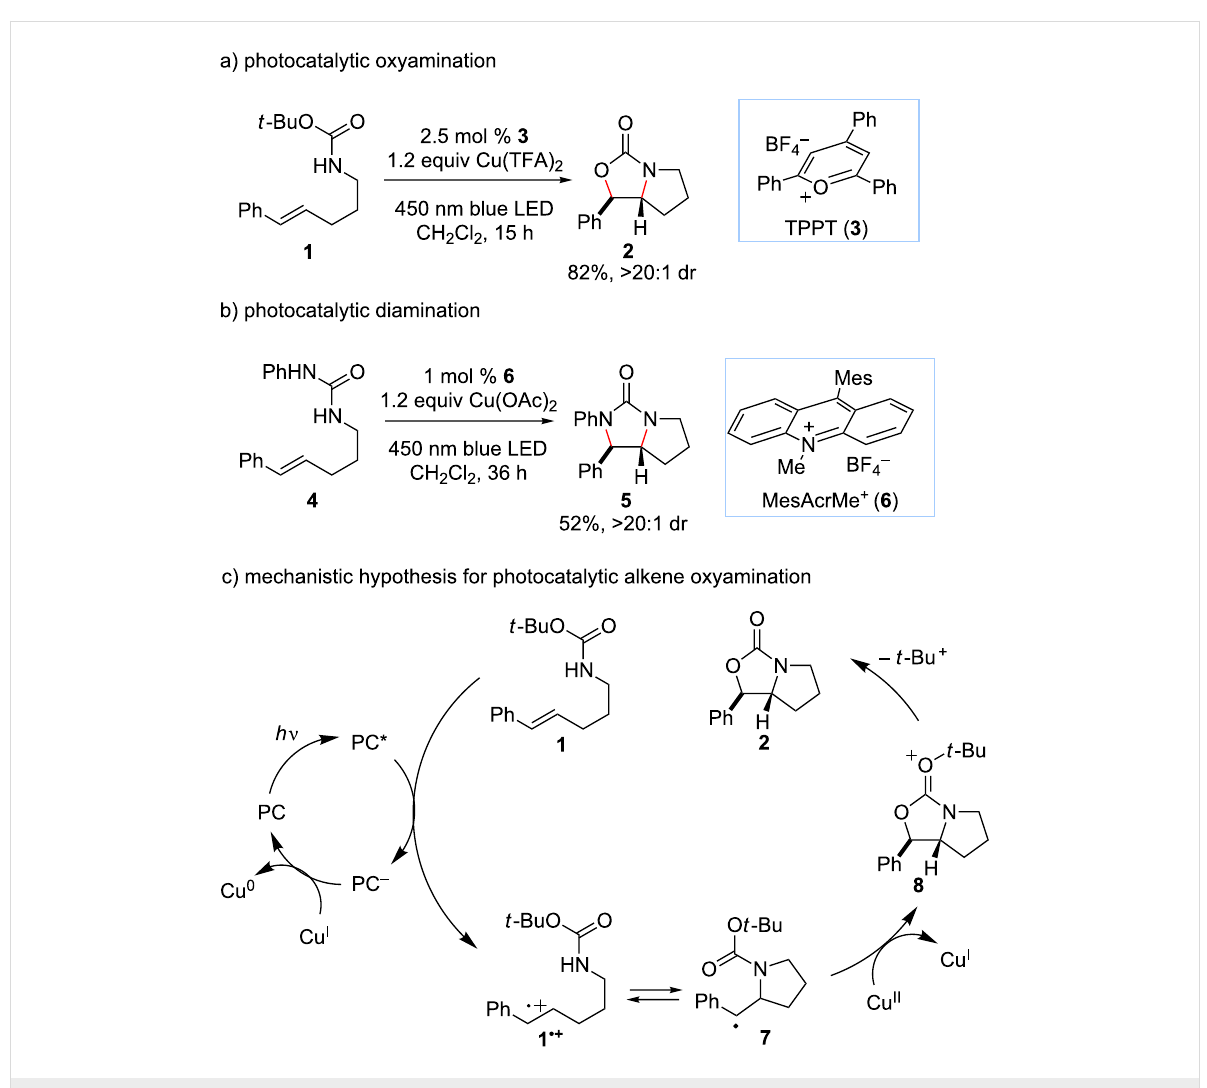
Figure 1: a) Photocatalytic oxyamination, b) photocatalytic diamination, and c) proposed mechanism for photocatalytic oxyamination using copper(II) as a terminal